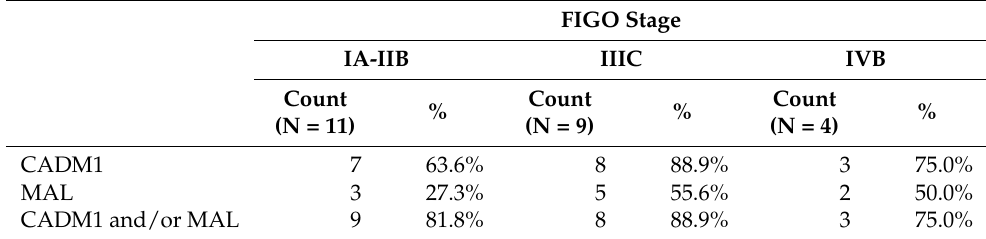
Table 3. CADM1, MAL, and CADM1 and/or MAL methylation status of blood samples from 24 cervical cancer patients in relation to tumor stage (FIGO classification 2019).